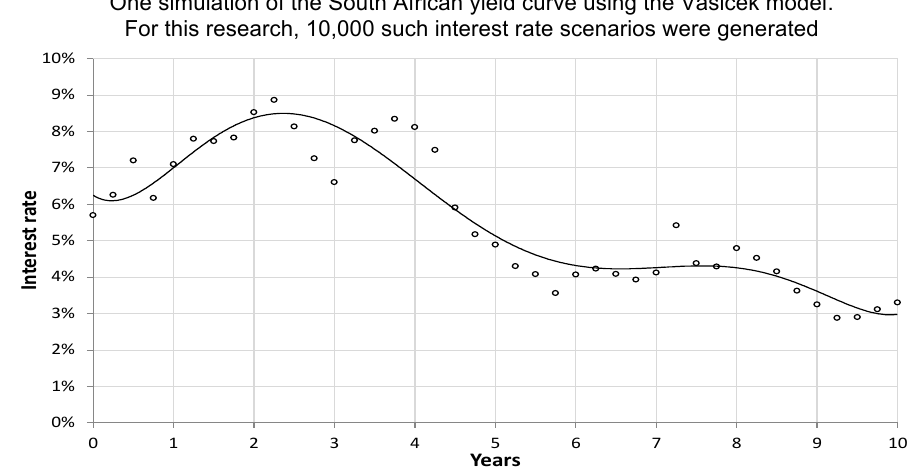
One simulation of the South African yield curve using the Vasicek